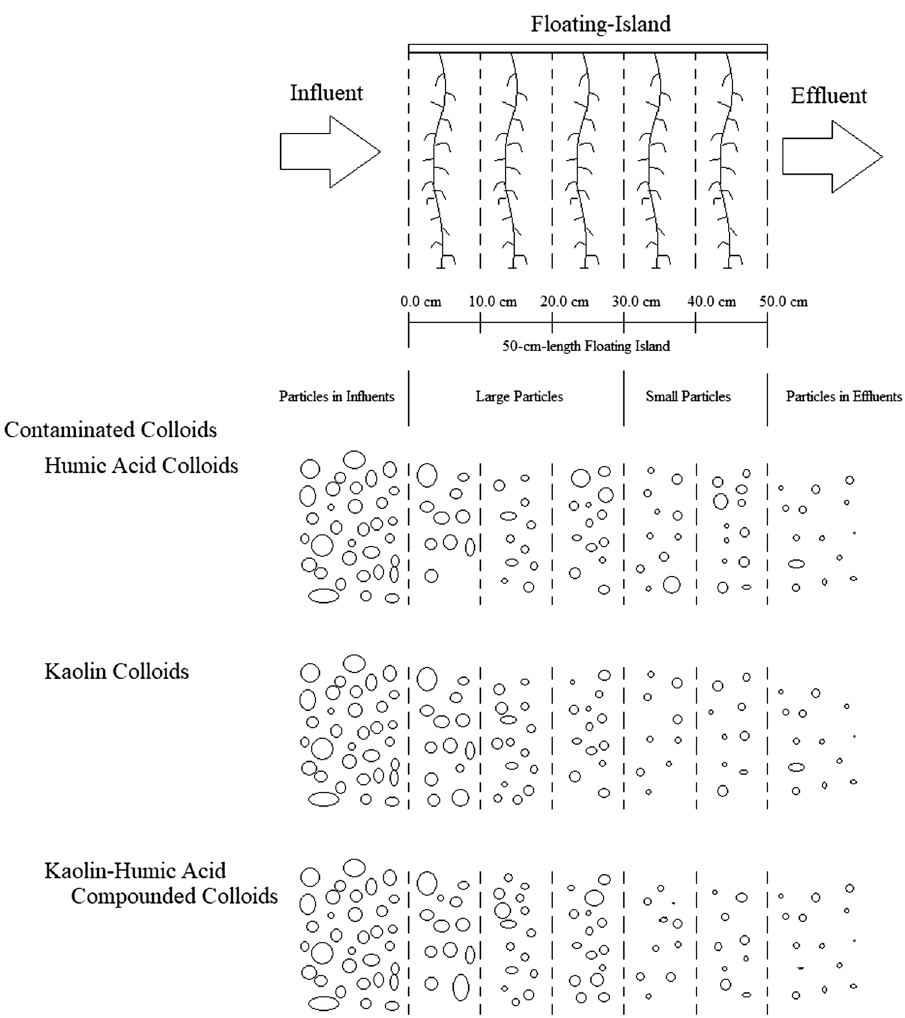
Fig. 4 Transport behaviors of humic acid, kaolin and kaolin– humic acid compounded col‑ loids on naphthalene in floating